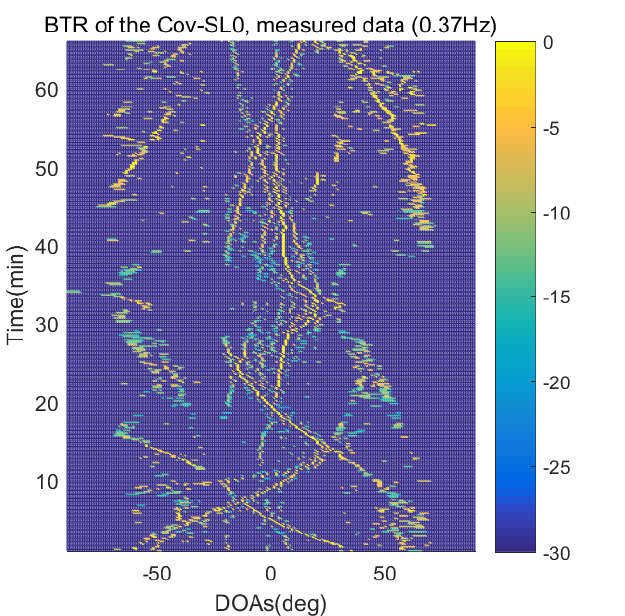
Figure 21. Bearing time records of the proposed scheme: 66 min, signal frequency = 0.37